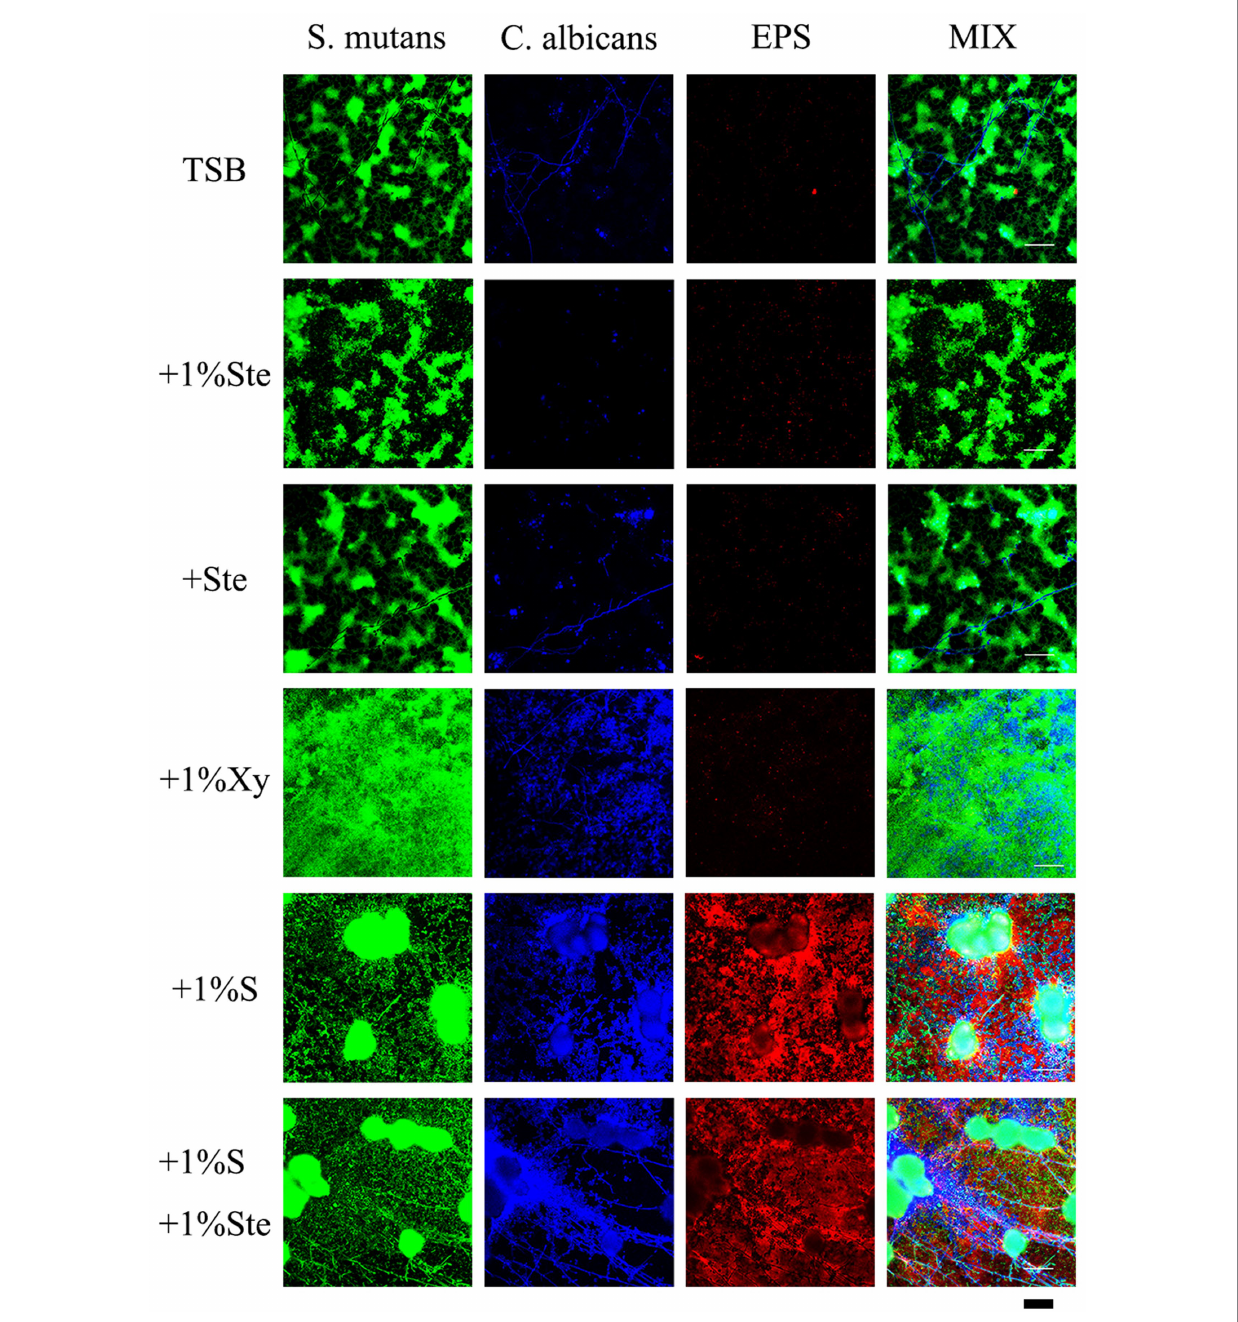
FIGURE 5 Effects of stevioside on dual-species biofilms and EPS by CLSM. Representative CLSM images of S. mutans – C. albicans and EPS after 24 h of culture in various media. S. mutans was stained with fluorescent green, C. albicans was stained with fluorescent blue, and EPS was stained with fluorescent red. Scale bar: 50 μ